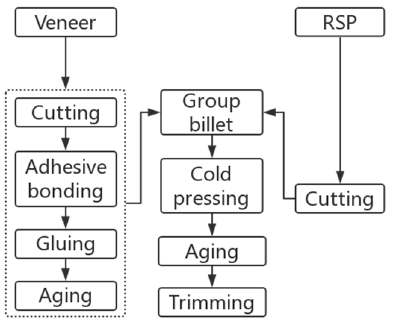
Figure 1. Manufacturing of veneered rice straw particleboard (RSP).